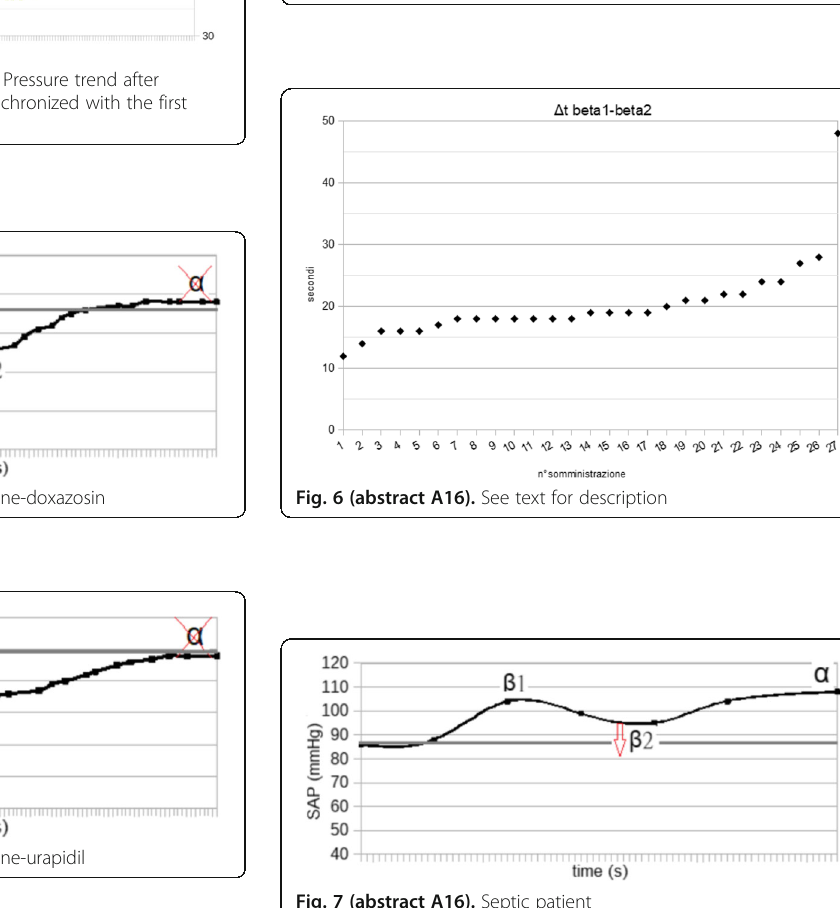
Fig. 5 (abstract A16). See text for description